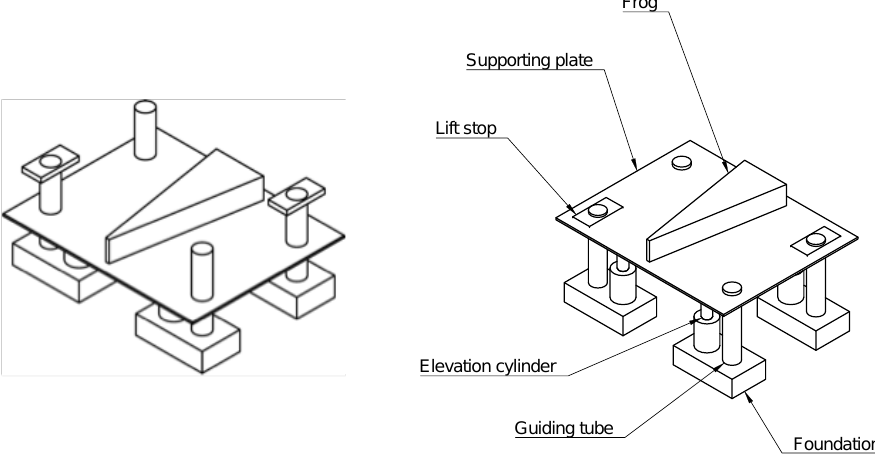
Figure 6. Components of the proposed mechanism .